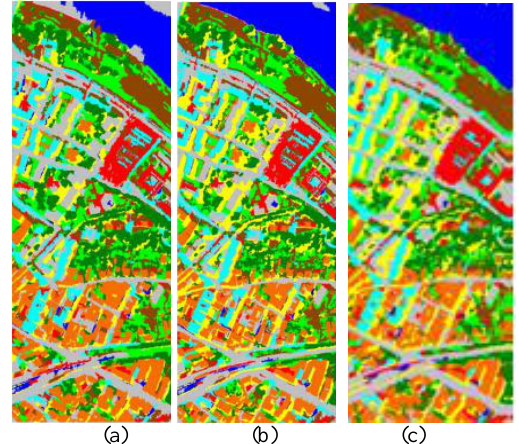
Figure 3. ROSIS Pavia Center data set. Classification maps obtained by (a) MSSC-MSF, (b) MSSC-HSEG+MV